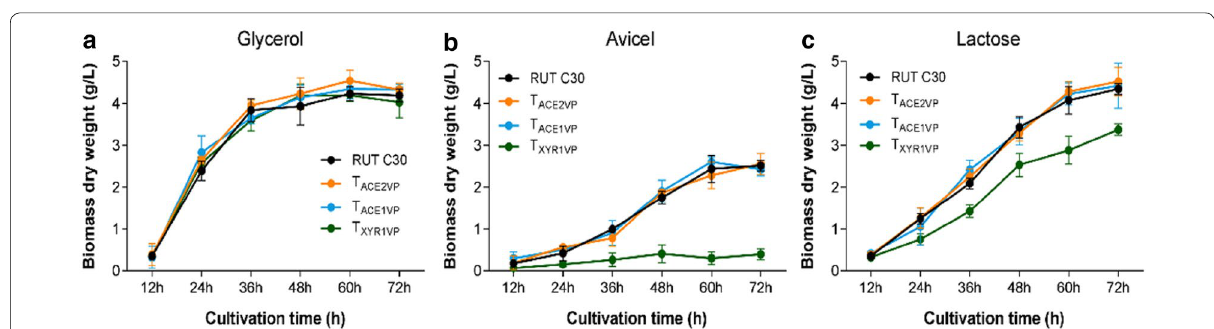
Fig. 2 Cell growth differences among T XYR1VP , T ACE2VP , and T ACE1VP cultured on glycerol ( a ), Avicel ( b ), and lactose ( c ). Error bars show the respective standard deviations of three biological